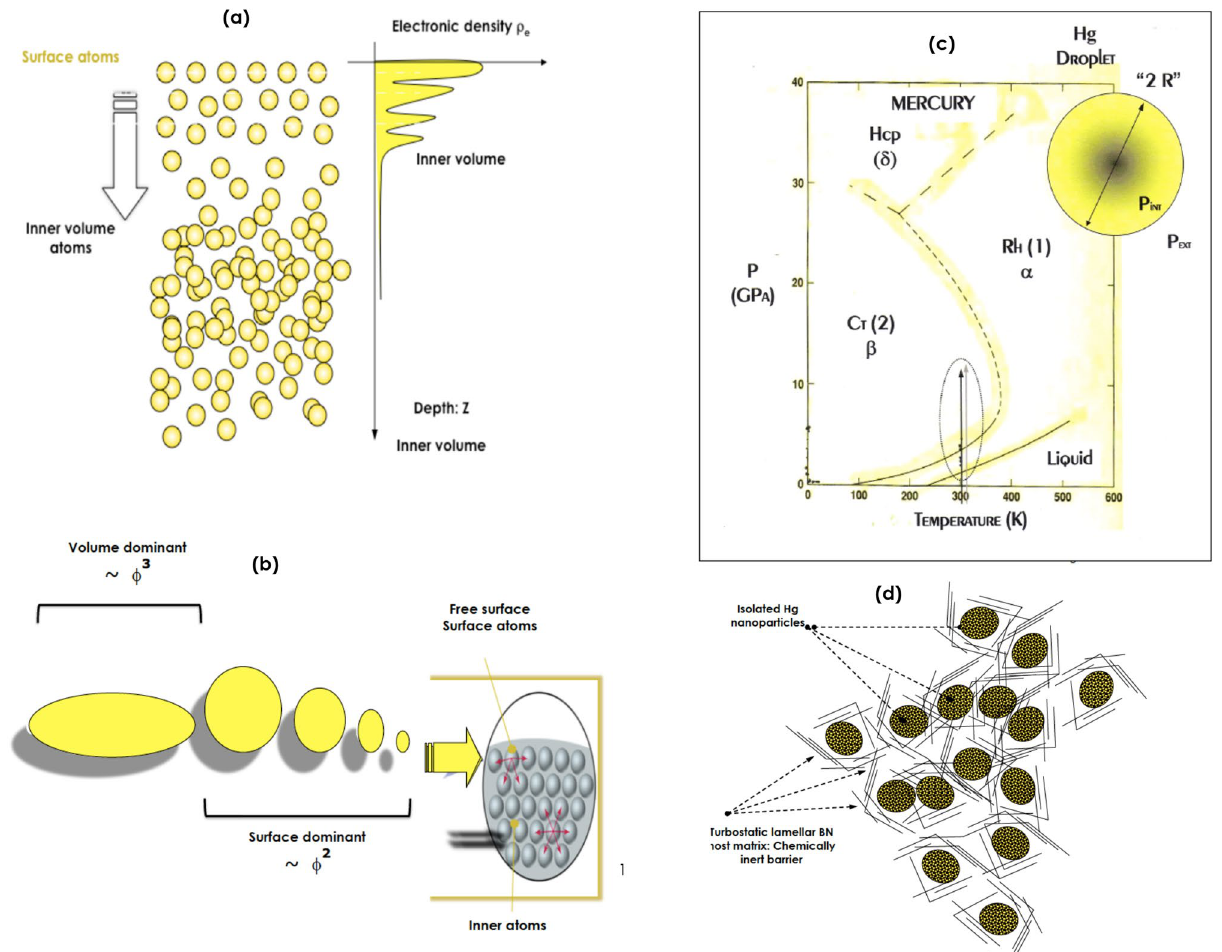
Figure 1. ( a ) Theoretical surface atomic ordering in liquid Hg with the corresponding in depth variation of the electronic density, ( b ) Schematic representation of volume and surface driven shape anisotropy in Hg droplets, ( c ) Hg Phase diagram (according to 11 ), ( d ) Schematic representation of the Hg nanoparticles confined in turbostratic BN chemically inert host